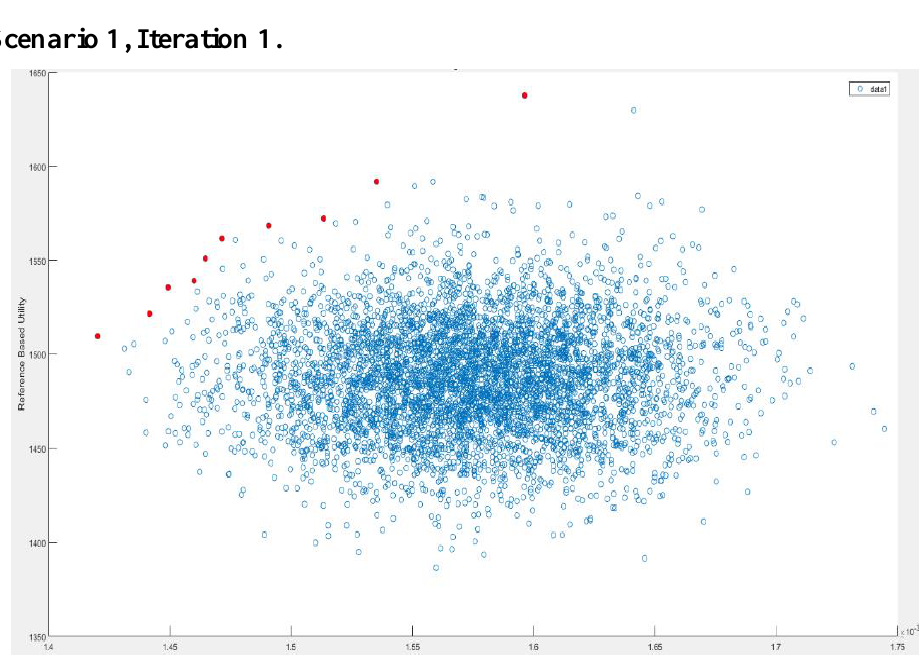
Figure 3. The Result Of Investigation Of 5,000 Different Portfolios In First Iteration Of Scenario 1